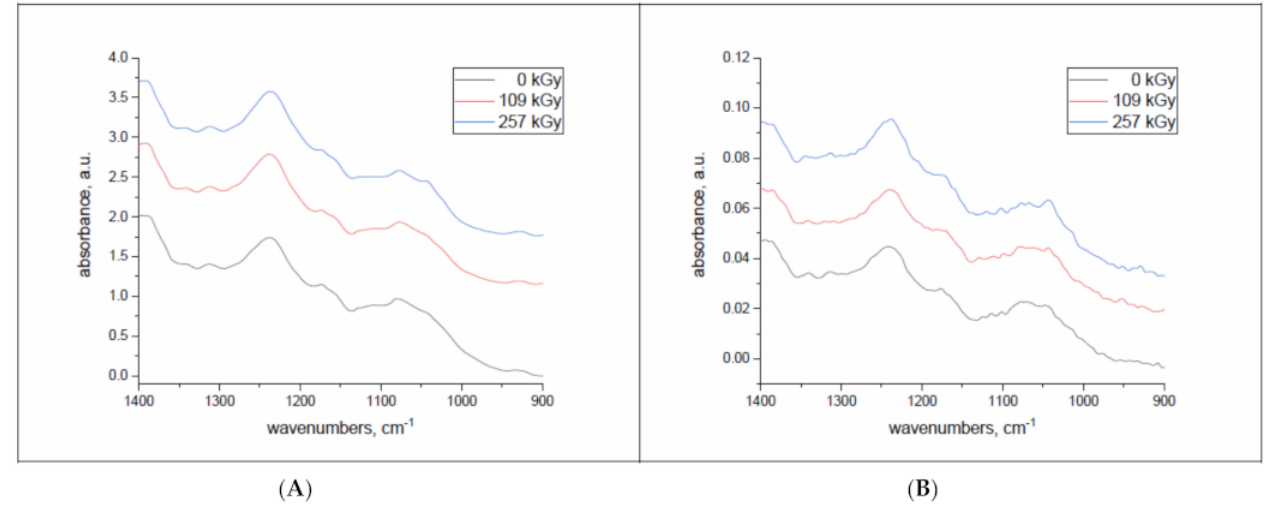
Figure 1. Selected FTIR spectra of wool samples pre-conditioned at 10% RH taken 26 days ( A ) and 178 days ( B ) after